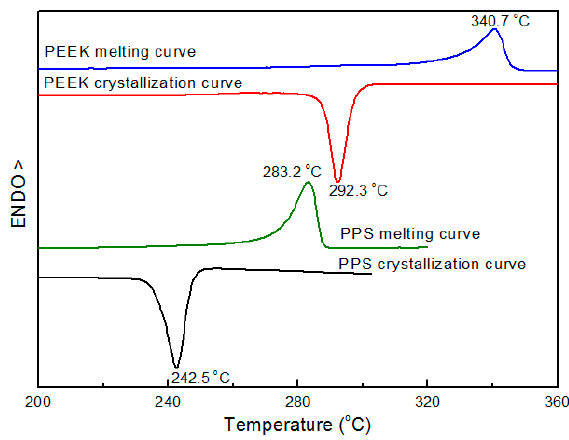
Figure 1. Crystallization and melting thermograms of neat PPS and PEEK.